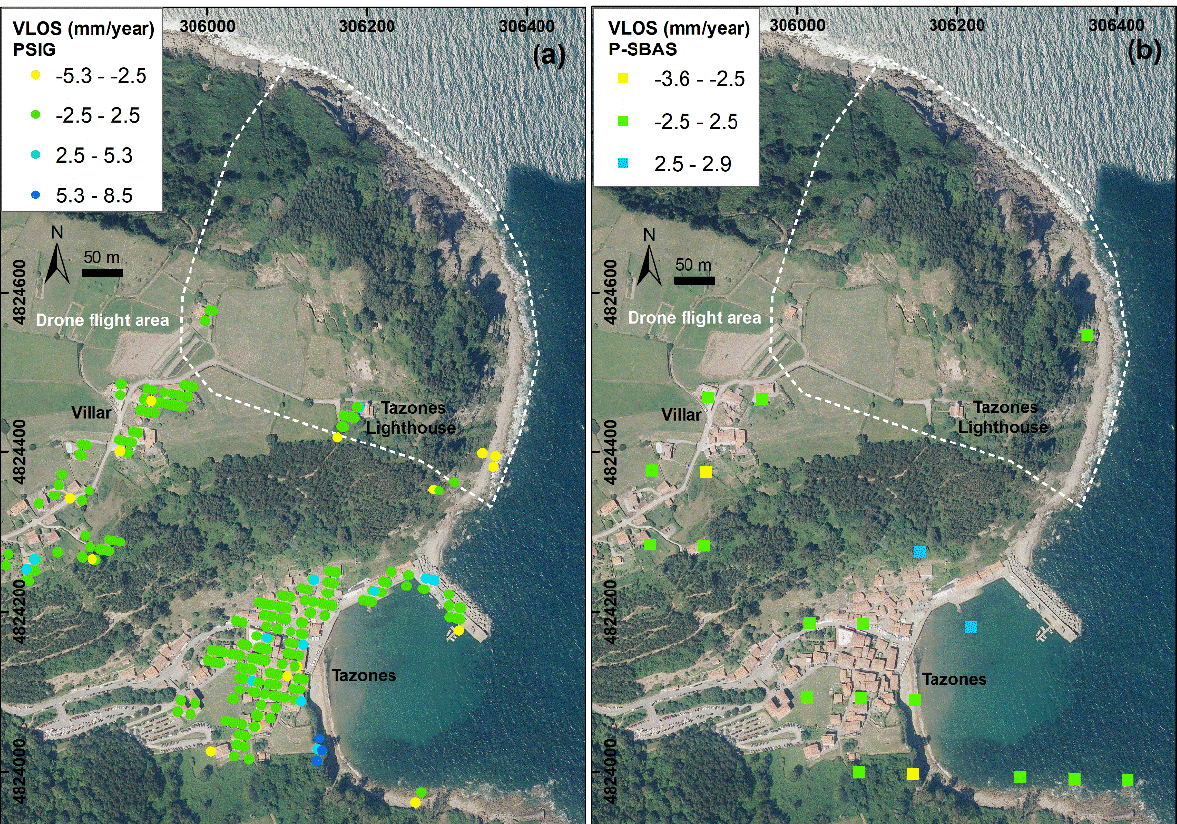
Figure 3. Tazones Lighthouse area LOS mean deformation velocity maps (mm yr −1 ). UTM coordi- nates referenced to ETRS89 30T. ( a ) LOS velocity map obtained by PSIG approach (pixel resolution: 14 × 4 m); ( b ) LOS velocity map obtained by P-SBAS processing of GEP service (pixel resolution: 90 × 90 m). OrtoPNOA 2017 CC-BY 4.0 scne.es.